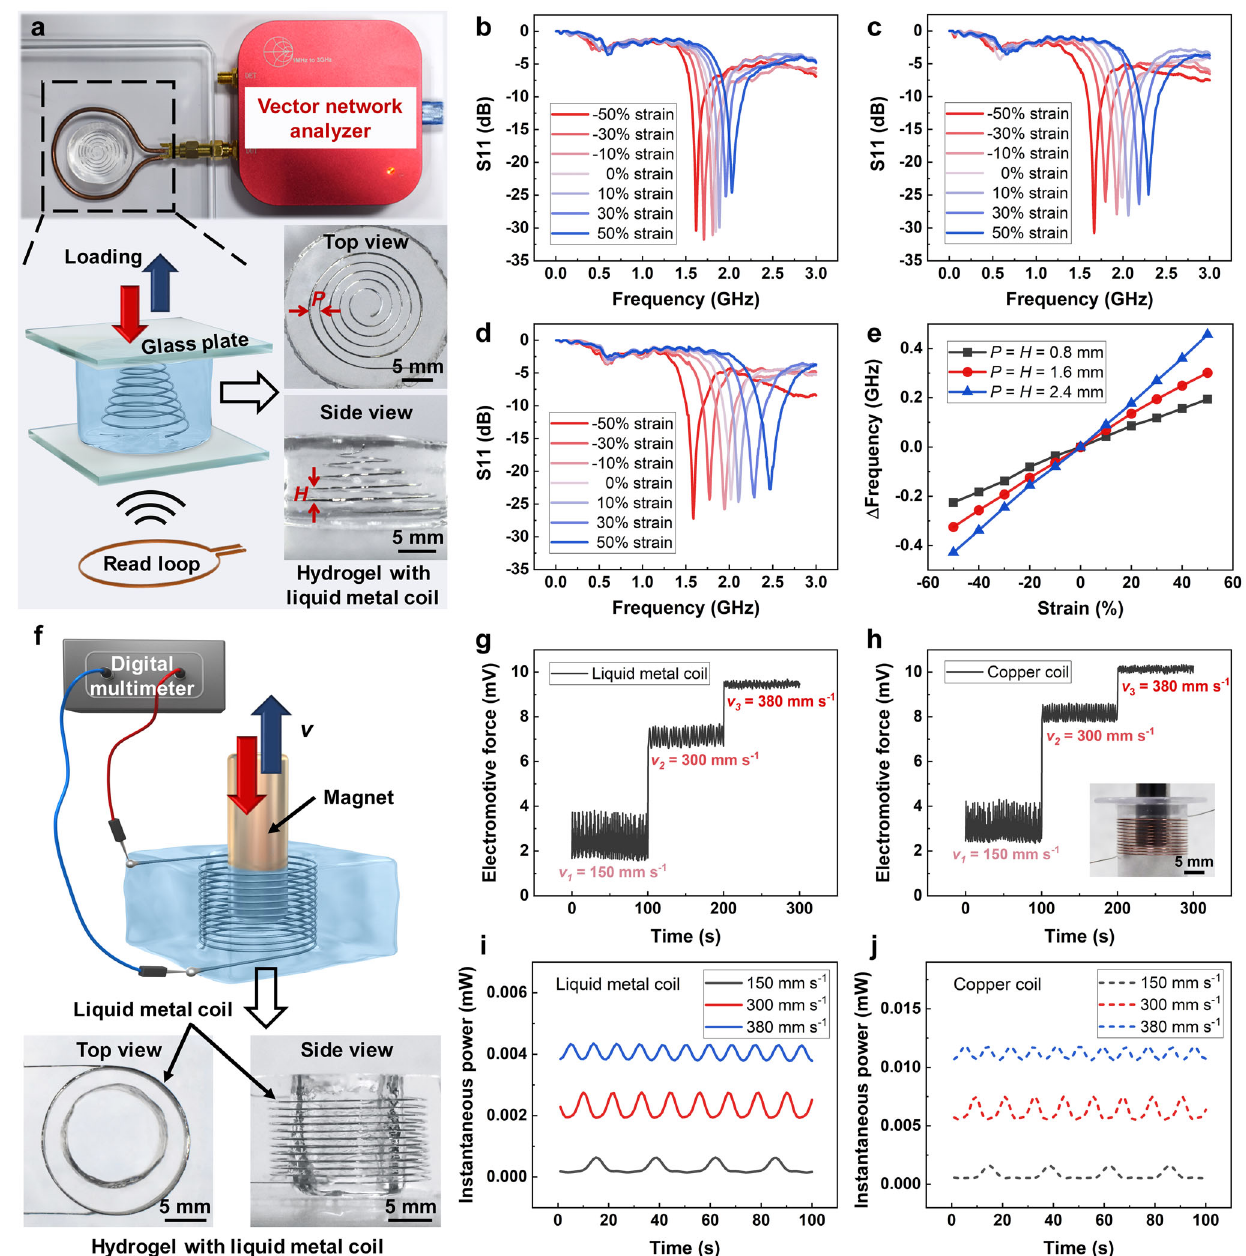
Fig. 5 Liquid metal-hydrogel electronics for electromagnetic functions. a Liquid metal-hydrogel specimens and device used for the resonant sensor test. b – d The re fl ection (S11)-strain relationship of three sensors. b – d show S11 of the sensors with P = H = 0.8 mm, P = H = 1.6 mm, and P = H = 2.4 mm, respectively. e The variation of resonant frequencies of the hydrogel embedded with a liquid metal of three con fi gurations under different levels of compressive and tensile strain. f Liquid metal-hydrogel specimens and device used for the electromagnetic induction test. g , h Induced EMF generated by a liquid metal coil ( g ) and a copper coil ( h , for comparison) at different moving speeds of the permanent magnet. i , j The power is delivered to a resistive load (5 Ω ) of the electromagnetic generators with a liquid metal coil ( i ) and a copper coil ( j ) at different